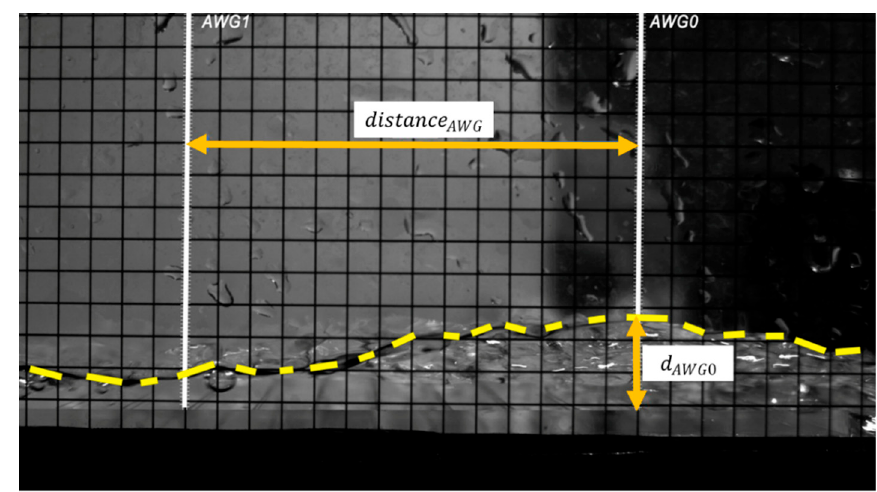
Figure 7. Lateral view with high-speed camera (CAM2).